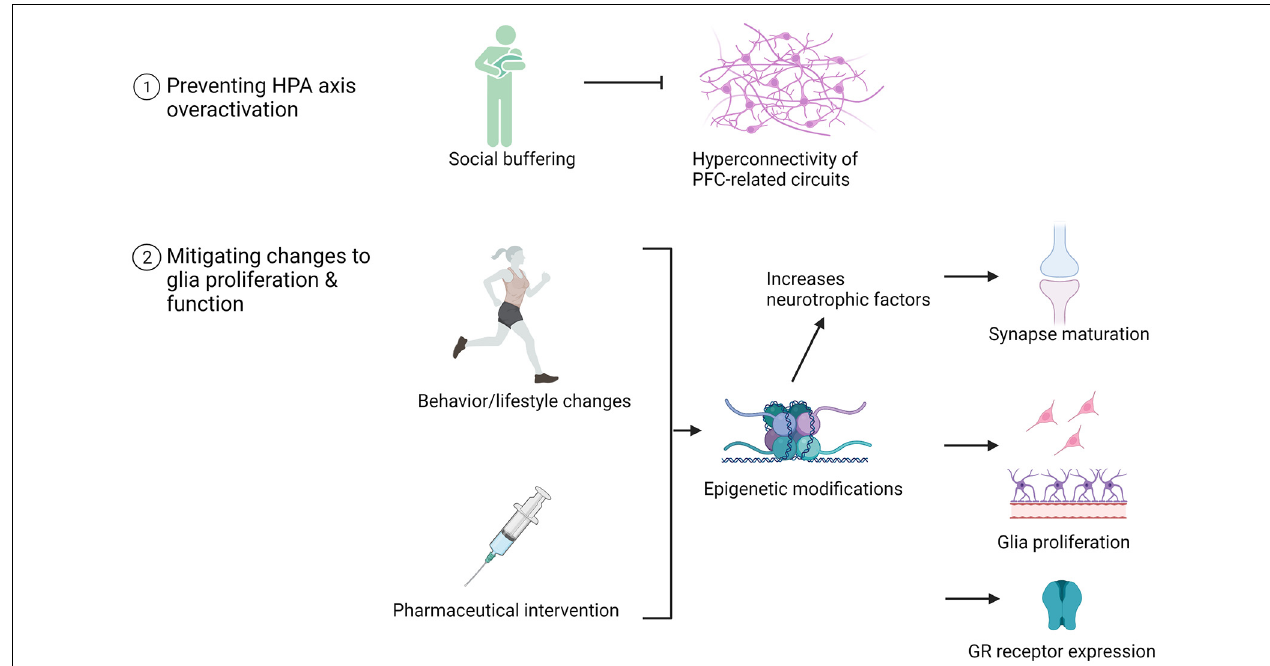
FIGURE 4 | Examples of pharmaceutical and behavioral therapeutic interventions that promote neurodevelopment in adolescents with a history of ELA. The impact of these interventions on brain structure, function, and glia number are listed.